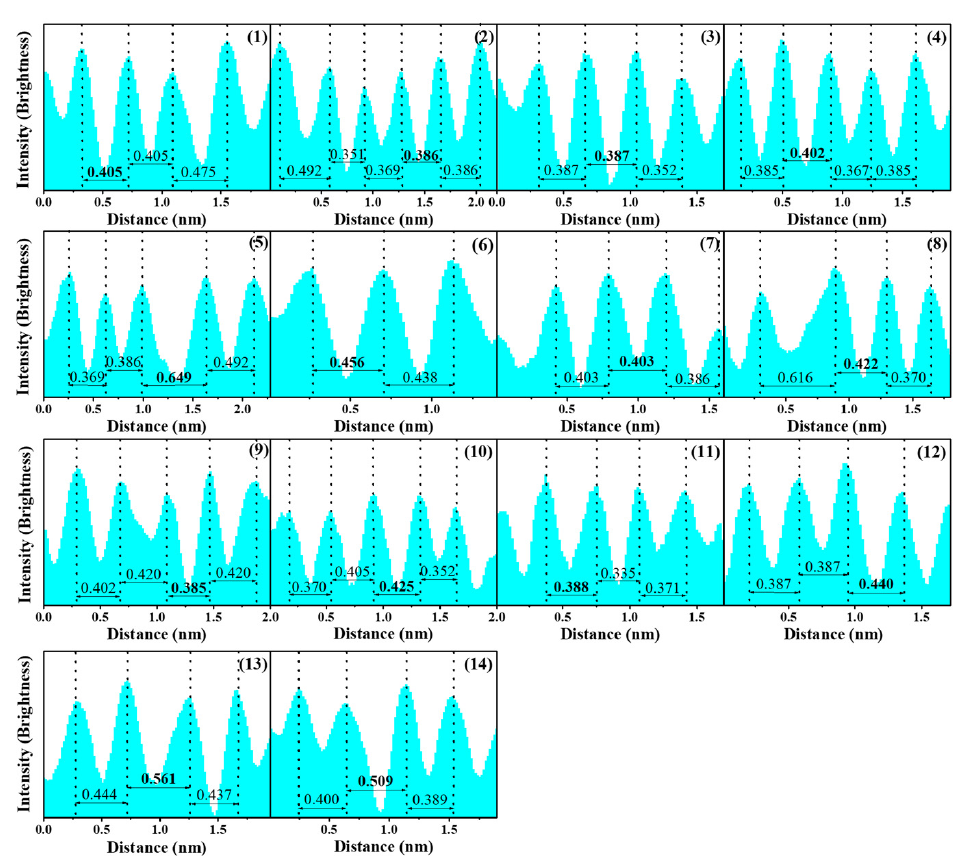
Figure 4. TEM images of ( a – c ) MRGO-HS. ( d ) HRTEM image of MRGO-HS with the multi-layer structure indicated by the red line.